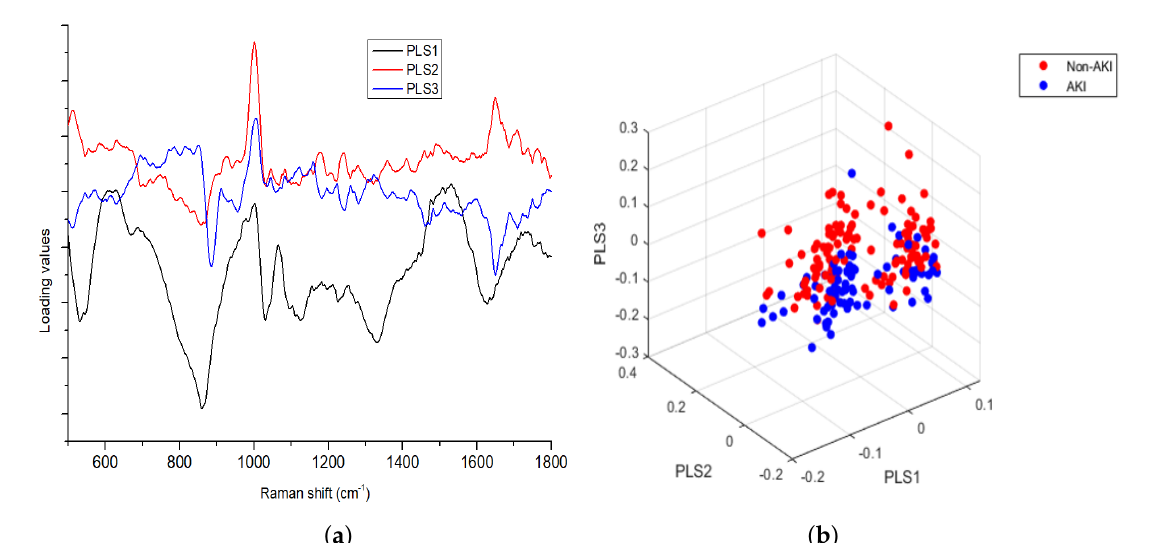
Figure 3. PLS ( a ) three loading factors and ( b ) 3D scatter